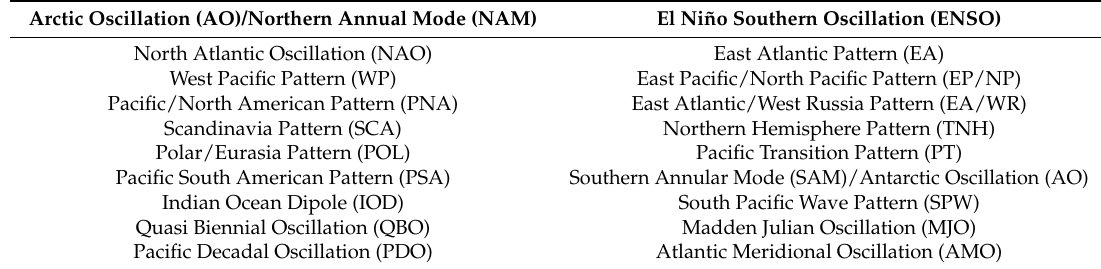
Table 1. A selection of teleconnection patterns and indices (Source: McGregor [6]). Arctic Oscillation (AO)/Northern Annual Mode